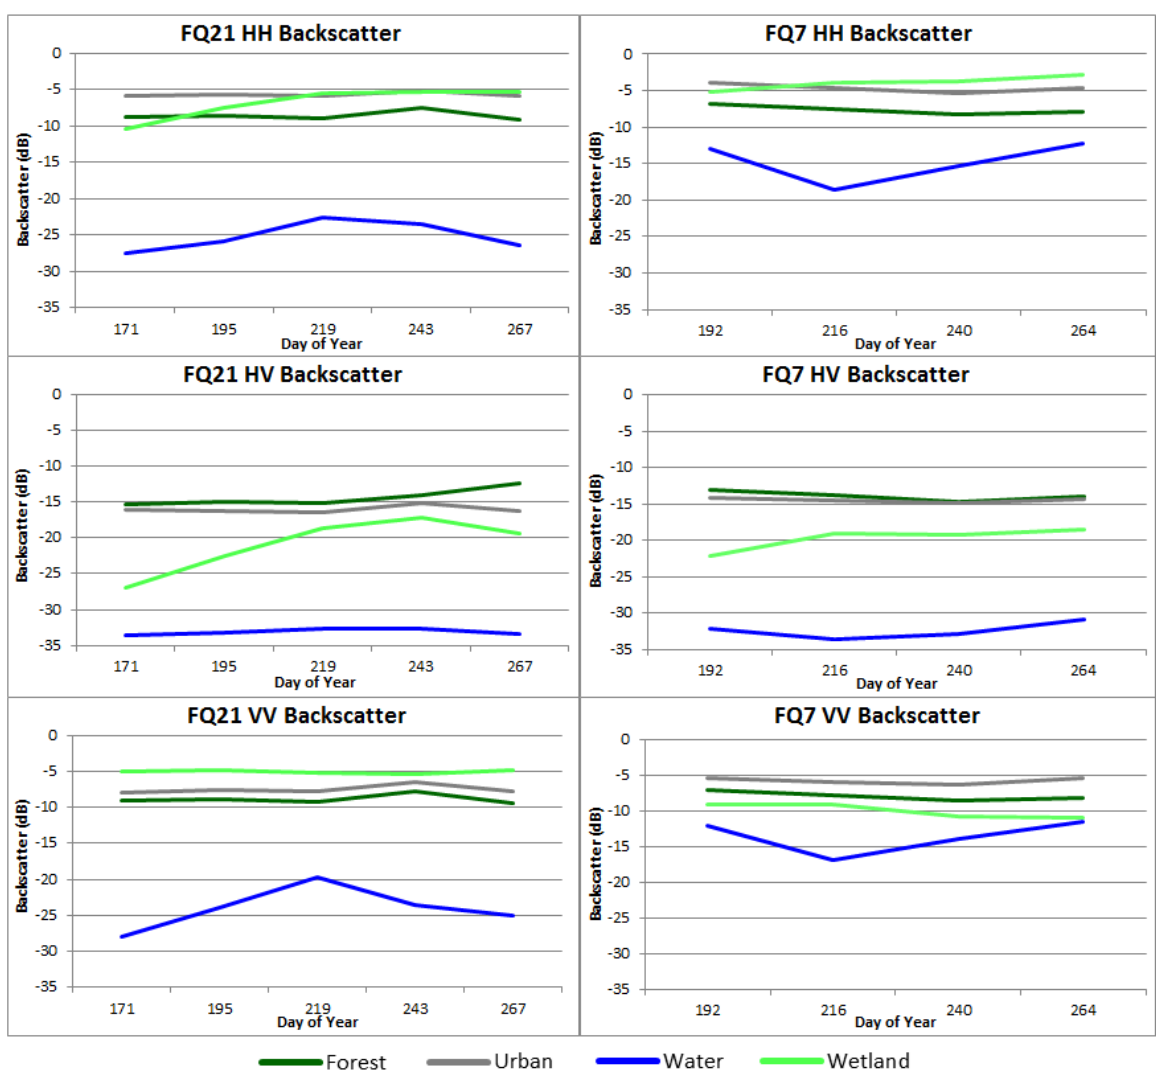
Figure 4. HH ( Top ), HV ( Middle ), and VV ( Bottom ) backscatter intensities for 41° ( Left ) and 26° ( Right ) incidence angles of land cover targets based on RADARSAT-2 fine quad beam